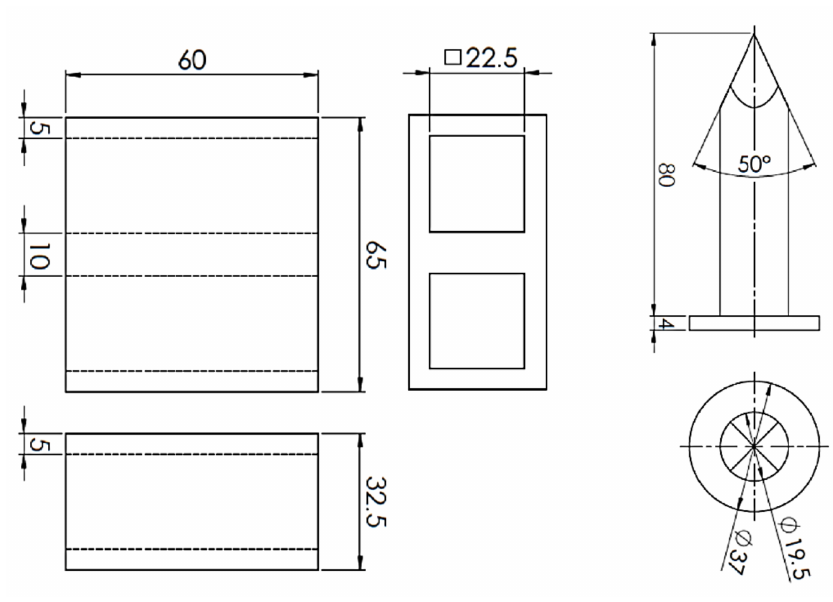
Figure 2. Scheme of collapsibility test method (mm).